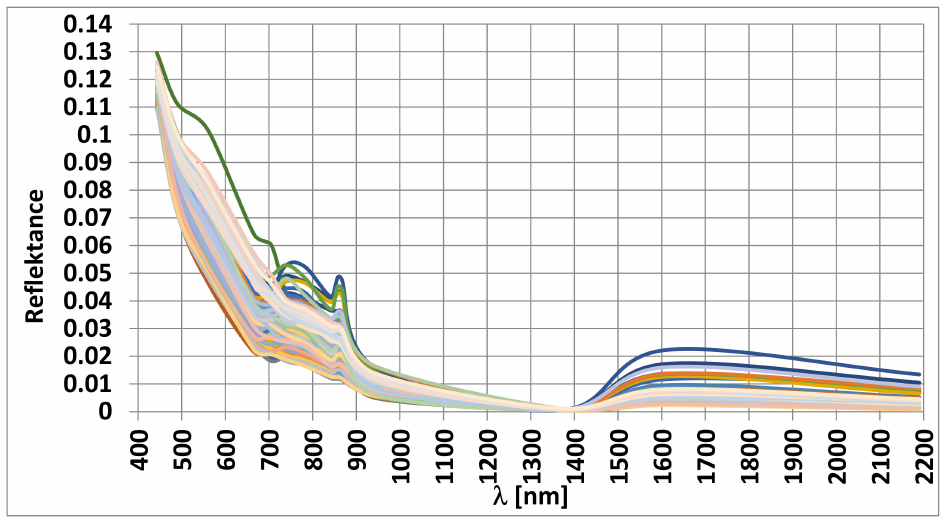
Figure 7. Reflectance at different measuring points of Lake Dobczyce in the years 2016–2021, after a normalization of the original reflectance from the